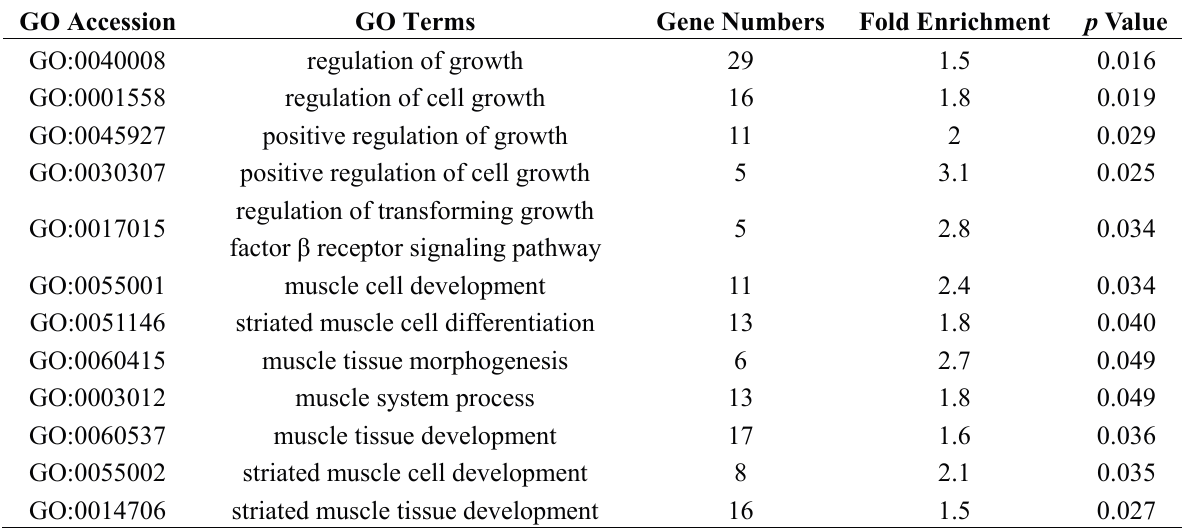
Table 5. Growth related biological processes identified by GO analysis for target genes of 22 highly differentially expressed